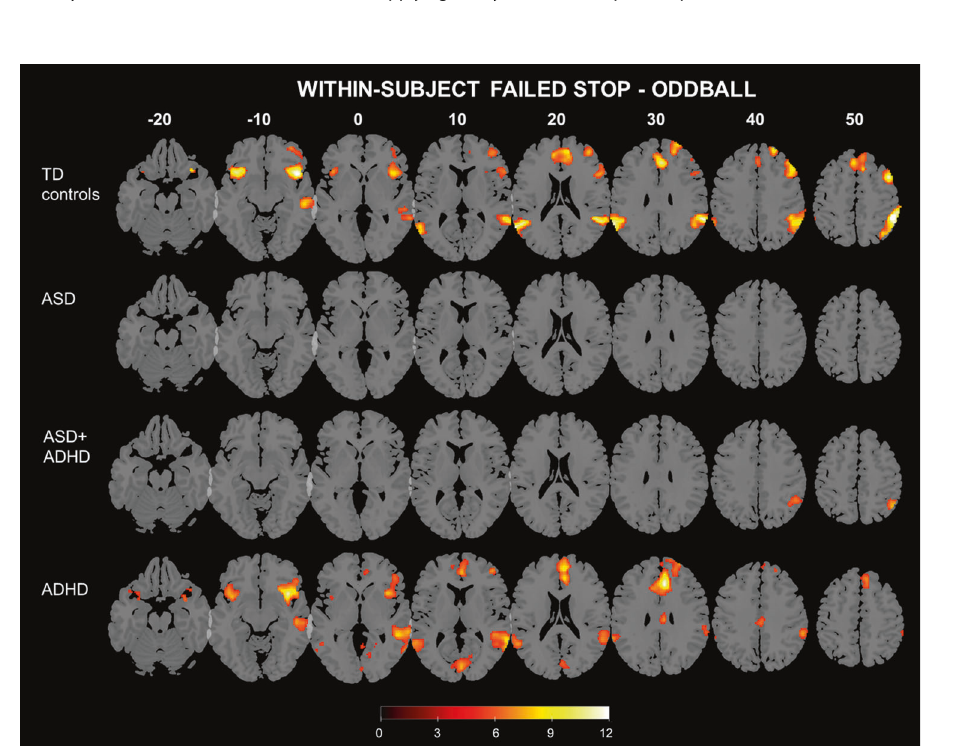
Fig. 1 Whole-brain within-subject activation during Failed Stop contrasted with Oddball trials. Signi fi cant cluster of activation in groups of participants with typically development, ASD, ASD + ADHD and ADHD, formed with a peak voxel threshold of p < 0.001, uncorrected, and a cluster extent threshold of p < 0.05, applying family-wise error multiple comparison